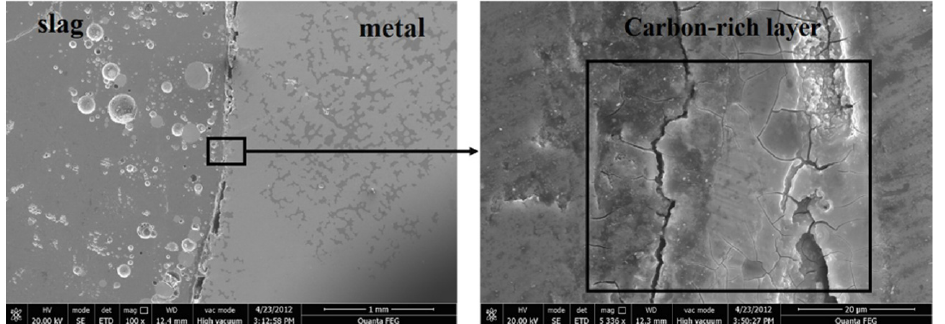
Figure 12. Interfacial morphology of Fe-13Mn-5Al alloy and low SiO 2 flux when holding 7 min at 1873 K.